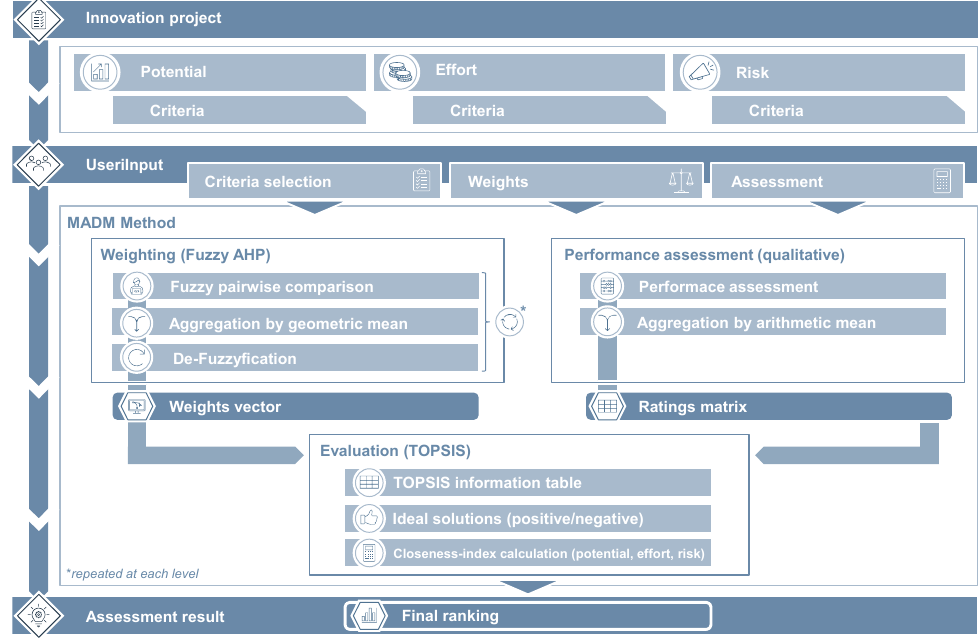
Figure 8. Overview of the approach for the holistic assessment of innovation in manufacturing.